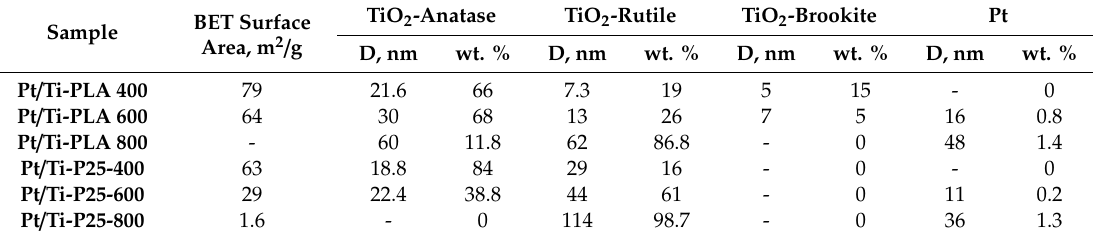
Table 1. Phase composition and percentage in Pt/Ti-PLA and Pt/Ti-P25 samples by XRD data. Sample